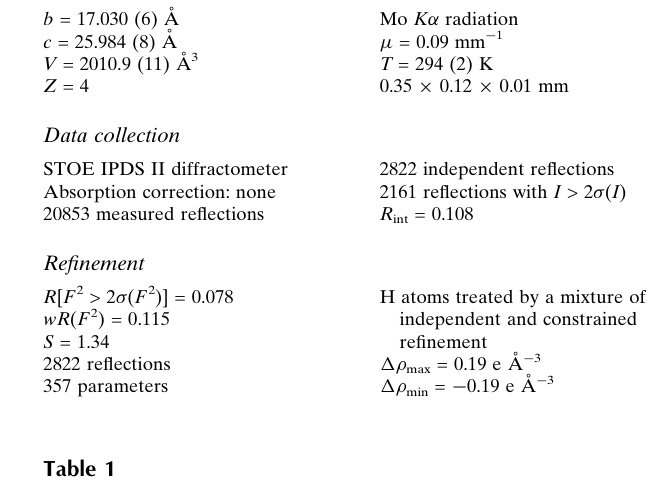
Hydrogen-bond geometry (A˚ , (cid:1)